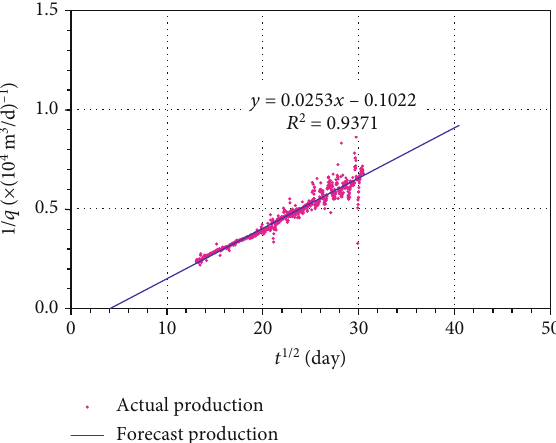
Figure 4: Cases with varied slope same intercept. Table 2: Reservoir and rock data.